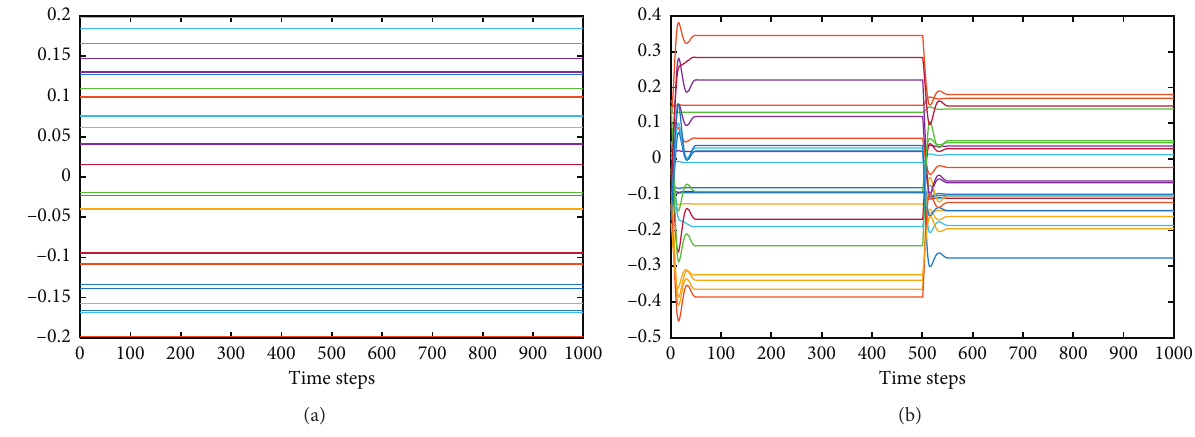
Figure 13: Keep (a) Wa1 and update (b) Wa2.